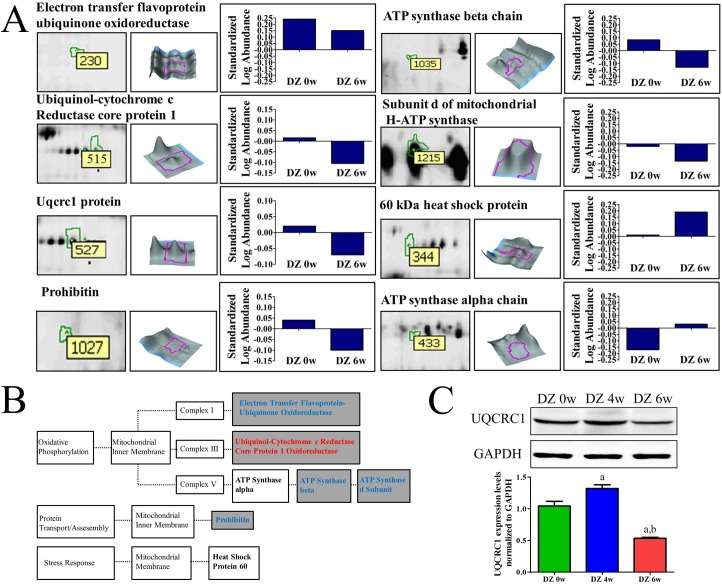
Identified proteins in DZ 6w group vs. DZ 0w group comparison and their functional/cellular location classification.(A) Identified differential proteins in the Group DZ 6w vs. DZ 0w comparison. For each identified protein, the magnified image of protein spot from the 2-DE gel is shown in left part of the panel; the 3D representation of the spot is shown in the middle part; and the graph of abundance ratio is shown in the right part. (B) Functional/cellular location classification tree of the identified proteins. Proteins were categorized by function and intracellular location. Dark gray boxes represent proteins that were down-regulated by diazoxide, and blank boxes represent proteins that were up-regulated by diazoxide. (C) Change of UQCRC1 expression in rat myocardium MIM with different time diazoxide treatment. (Data were expressed as mean ± SD, a: P < 0.05 vs. group DZ 0w; b: P < 0.05 vs. group DZ 4w; n = 5).